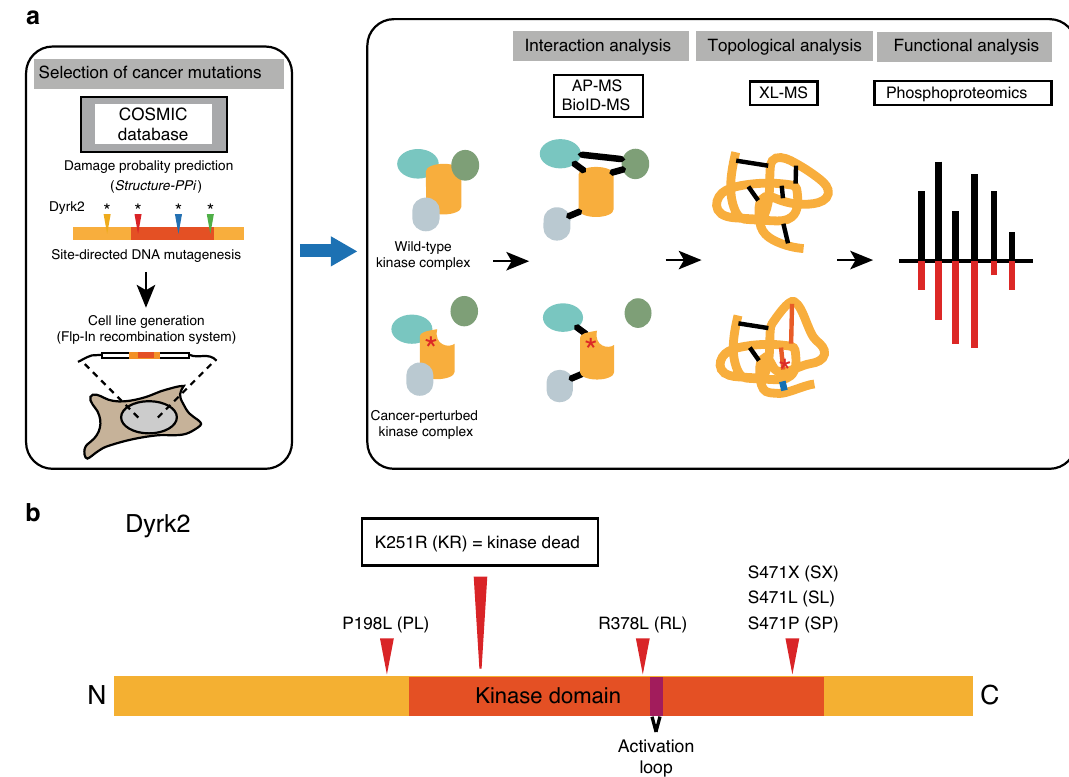
Fig. 1 Selection of cancer-related mutations for the application of a multi-layered proteomic work fl ow. a Applied multi-layered proteomic work fl ow integrating interaction analysis (AP – MS and BioID – MS), topological analysis (quantitative cross-linking (XL) MS), and functional analysis (phosphoproteomics). b Scheme of the position of the selected cancer-related point mutants in